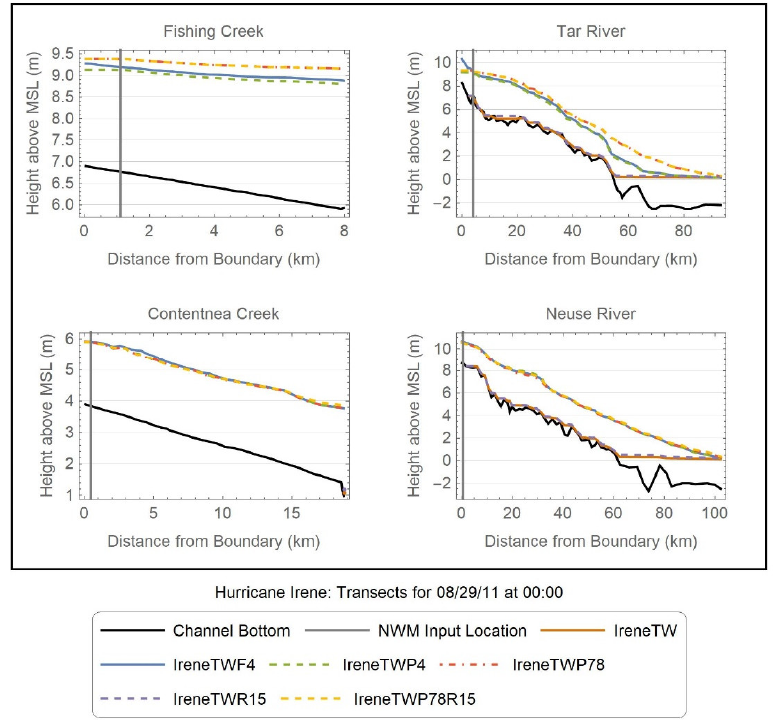
Figure 11. Water level results from Hurricane Irene on 29 August 2011 for the four main stems in the Neuse-Tar-Pamlico area of North Carolina under the six simulation conditions give in Table 3. Black lines represent the channel bottom and solid gray vertical lines indicate the locations where the lateral inflow is input into ADCIRC from the NWM.